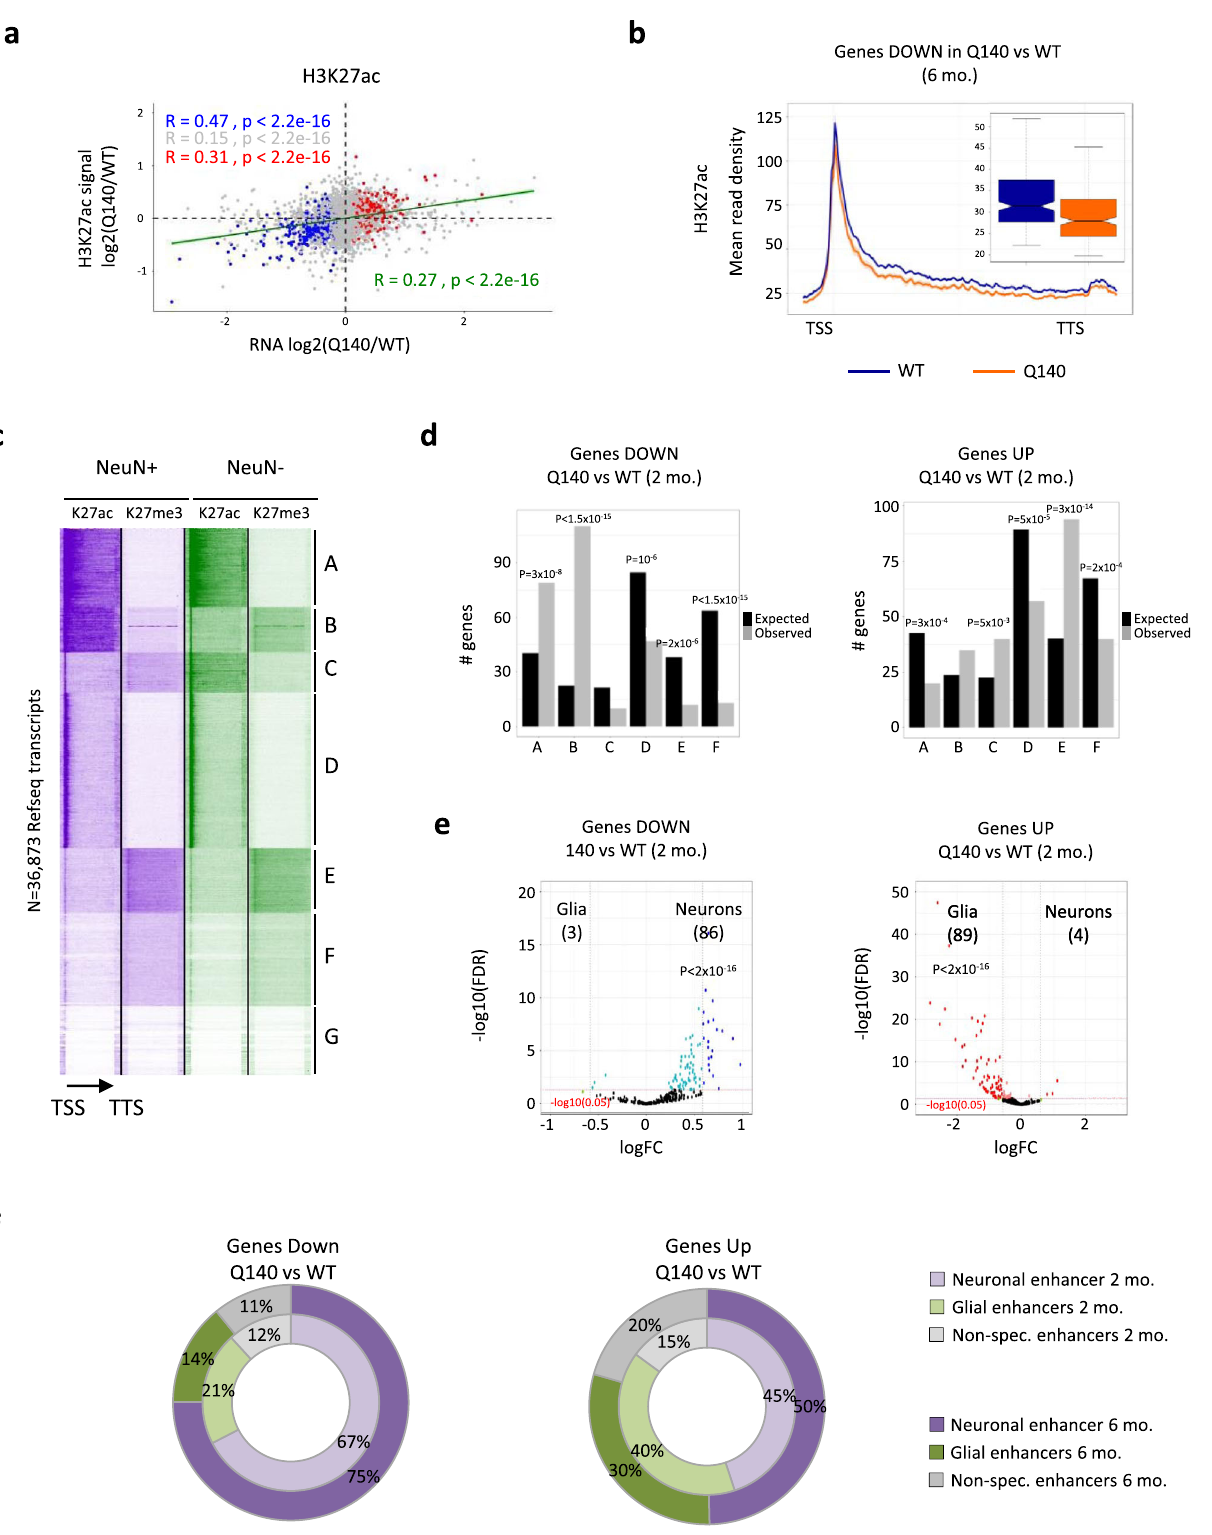
advantage of RNAseq data on HD KI mice 5 (Supplementary Fig. 9a). Integrated analysis was performed between H3K27ac ChIPseq data generated on 2- and 6-month-old striatal tissue of Q140 and WT mice and RNAseq data generated on same mouse line, tissue and ages. Linear regression analysis showed that H3K27ac and mRNA changes between Q140 and WT samples were signi fi cantly and positively correlated, with a correlation